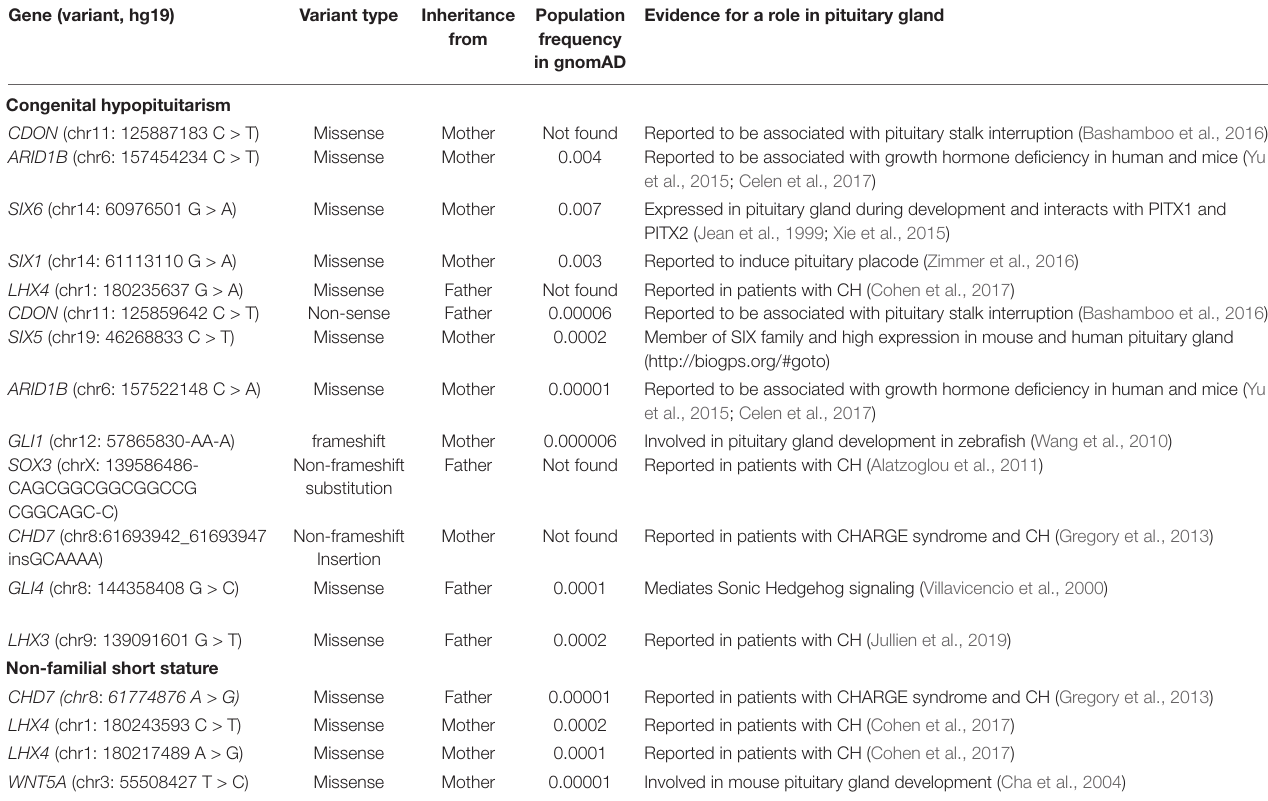
TABLE 3 | Genetic variants found in 42 known pituitary-associated